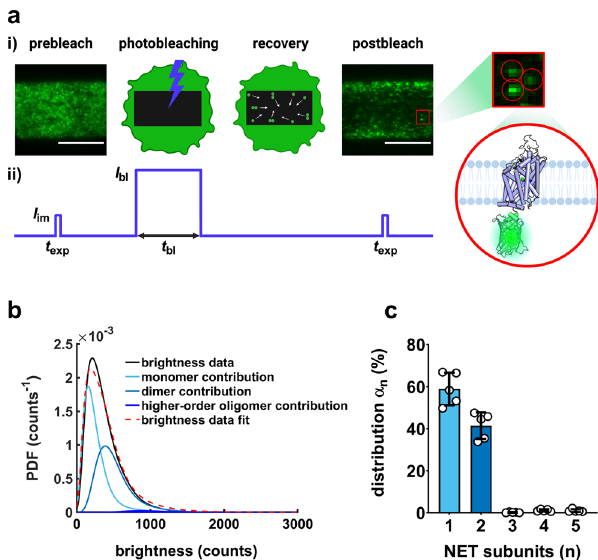
Fig. 1 Determination of mGFP – hNET oligomer distribution using single- molecule brightness analysis. a Concept of TOCCSL runs in mGFP-hNET- transfected CHO cells. i) A prebleach image is recorded and an aperture- restricted area of the bottom cell membrane is subsequently photobleached for 2000ms ( t bl ) with a laser intensity of ~2 kW/cm 2 ( I bl ). During 5,000 ms of recovery time, unbleached molecules re-enter the bleached area by Brownian motion; thereafter, a postbleach image is recorded in which individual molecules are distinguishable. The TOCCSL image was acquired with 5 ms excitation time ( t exp ) and laser intensity of 0.4 – 0.6 kW/ cm 2 ( I im ). The scale bar of the prebleach and postbleach image is 10 µ m. ii) Timing protocol for a typical TOCCSL experiment, plotted as time vs . laser intensity. b Representative brightness distribution of the oligomeric fractions obtained from TOCCSL runs on ten cells, plotted as probability density function (PDF). c NET co-exists as monomers (~60%) and dimers (~40%) at the plasma membrane. Each data point represents an independent experiment with TOCCSL runs on 15 cells. Bars represent means ±